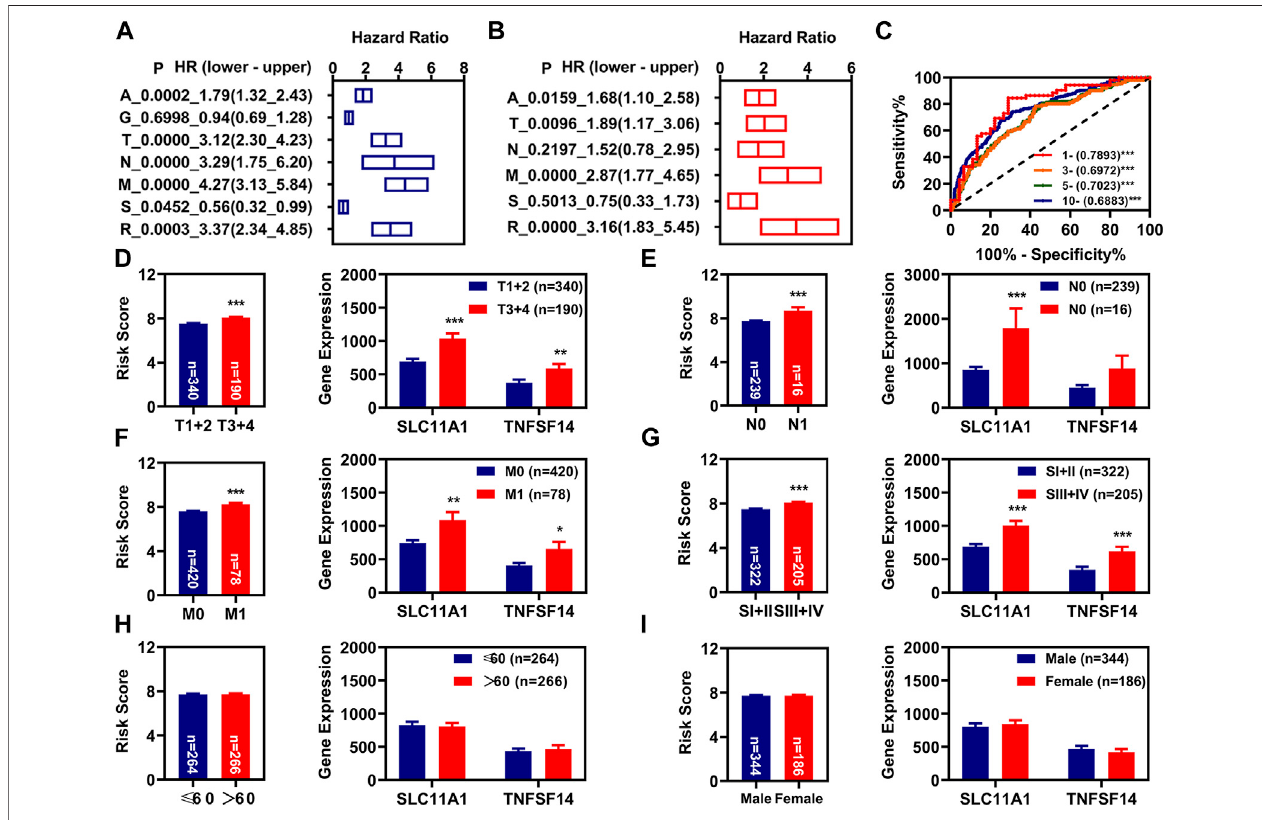
FIGURE 3 | Independent prognosis factors and correlation analysis. (A) , K-M analysis of prognosis factors. (B) , Multivariate Cox regression analysis of prognosis factors. (C) ,The1-year,3-year,5-year,and10-yearROCoftheriskmodelshowthatallAUCvalueswereover0.60. (D – G) ,Correlationofriskvalues (left) andthesetwoFR- DELs (right) expressions with the pathologic T (D) , pathologic N (E) , pathologic N (F) , pathologic stage (G) , age (H) , and gender (I) . * p < 0.05, ** p < 0.01, *** p <